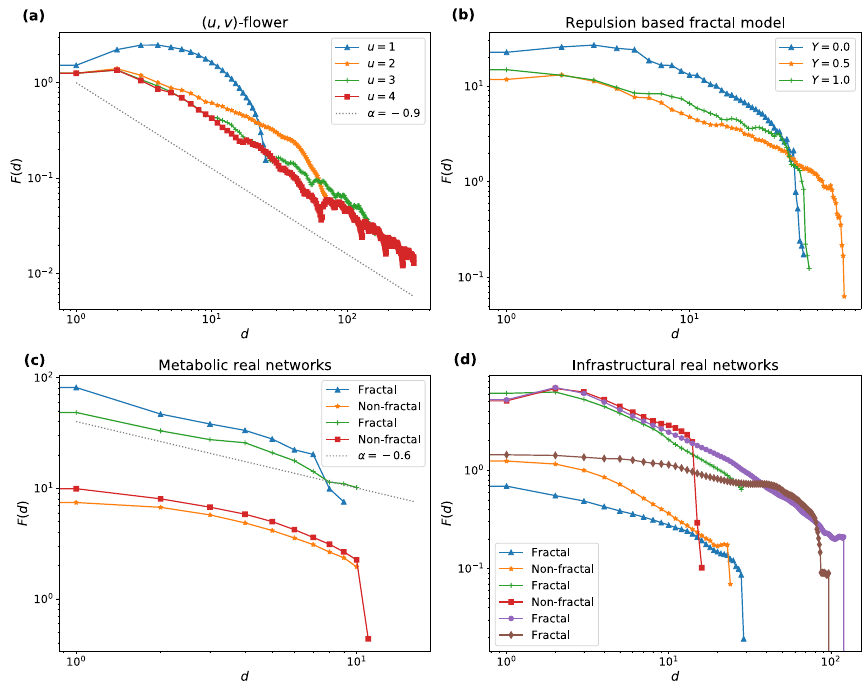
Fig. 17 Results of the fluctuation analysis on a log‑log scale for some examples of the a ( u , v )‑flower, b Repulsion‑based fractal model. c illustrates the cases of some metabolic, d infrastructural real networks. The dotted grey lines on subfigures a and c are guides for the eye. Results for all of the examined networks can be found in the supplementary material (Zakar‑Polyák et al.